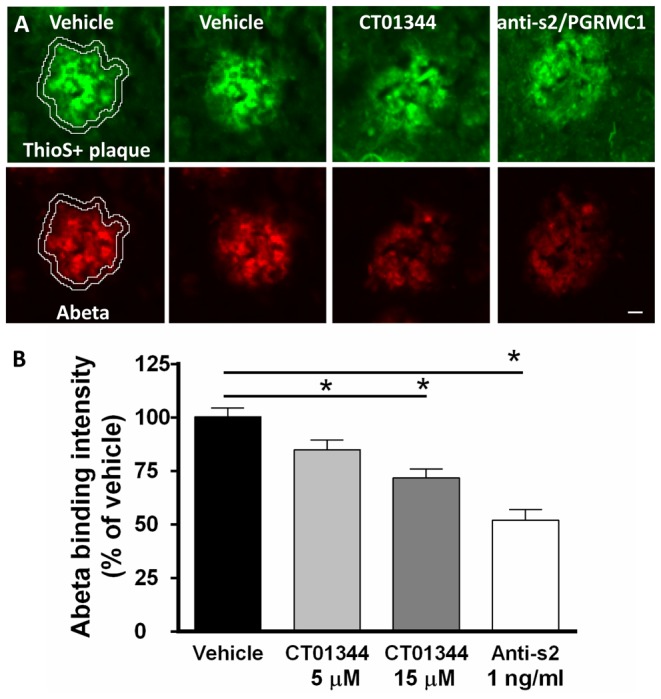
Antibodies and compounds directed against sigma-2/PGRMC1 dose-dependently displace endogenous human Abeta oligomers from specific tissue locations in Alzheimer's brain neocortical tissue sections.
A, Abeta oligomers located in a 2 micron halo surrounding compact thioflavin-S positive plaques is displaced from frozen postmortem human AD brain tissue sections (N = 7 patients) by C-terminal sigma-2/PGRMC1 antibody and receptor antagonist CT01344 (B) in a dose-dependent manner compared to vehicle-treated brain sections from the same individual (Spearman's rank order, rho  = −0.492, p = 0.038). All scale bars  = 20 microns. See Fig. S4 for details on quantification method.